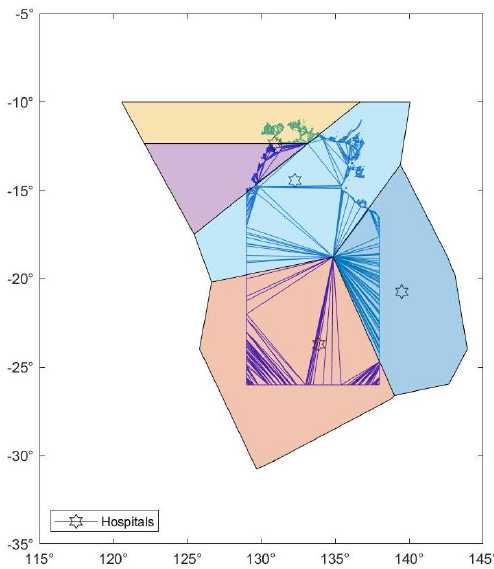
Figure A1. Northern Territory Triangulation by hospital catchment